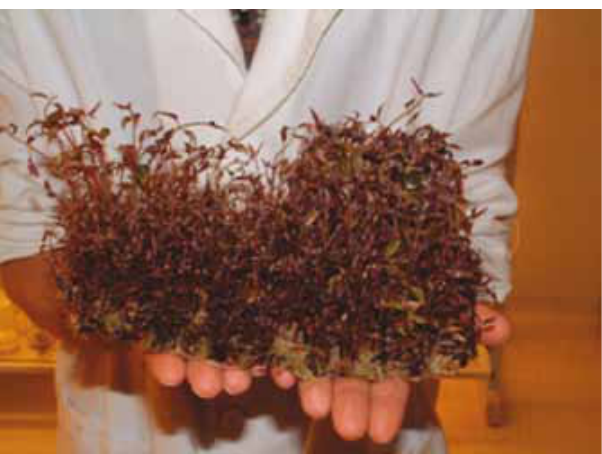
Figure 12: In vitro propagation of the without seed Brazilian ginseng (Pfaffia glomerata L.) in the bioreactor